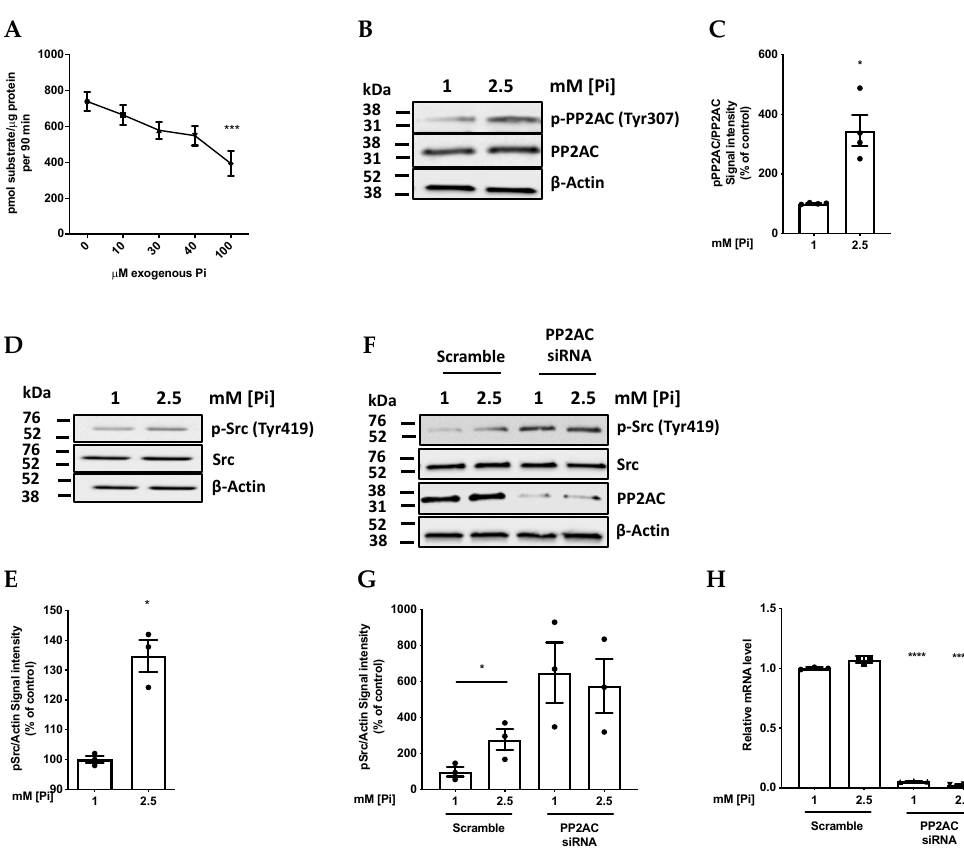
Figure 2. Pi inhibits PP2A and induces an increase in Src phosphorylation. ( A ) Direct inhibition by Pi of PP2A catalytic activity after pulling-down endogenous PP2A-C from EA.hy926 ECs lysates and subjecting this to phosphatase catalytic activity assay in the presence of exogenous Pi at the stated concentration using PP2A phosphatase substrate (Millipore Ref 17-313). n = 3, *** p = 0.0002 versus control without Pi. ( B ) Representative immunoblot demonstrating Pi-induced inhibitory phosphorylation of PP2A in intact EA.hy926 cells. E ff ect of 1.5 h Pi-loading hyperphosphatemia on expression of PP2AC and p-PP2AC (Tyr307). ( C ) Densitometry analysis of ( B ), n = 3, * p = 0.037. ( D ) Representative p-Src immunoblots probed using anti-p-Src (Tyr419) antibody and ( E ) corresponding densitometry analysis of ( D ) n = 3, * p = 0.023. ( F ) Representative immunoblots and ( G ) quantitative analysis by densitometry of the e ff ect of siRNA silencing of PP2A-C on Src phosphorylation during 1.5 h incubations of cells with 1 or 2.5 mM Pi. n = 3, * p = 0.0337. ( H ) Relative mRNA levels of PP2A-C in EA.hy926 cells transfected with scrambled siRNA and PP2A-C silencing siRNA for 1.5 h. After removal of the transfection medium and allowing an additional 24-h recovery period in growth medium, cultures were treated with 1 or 2.5 mM Pi, and RNA was extracted from the cells, reverse transcribed, and subjected to quantitative RT-PCR. n = 3, **** p <